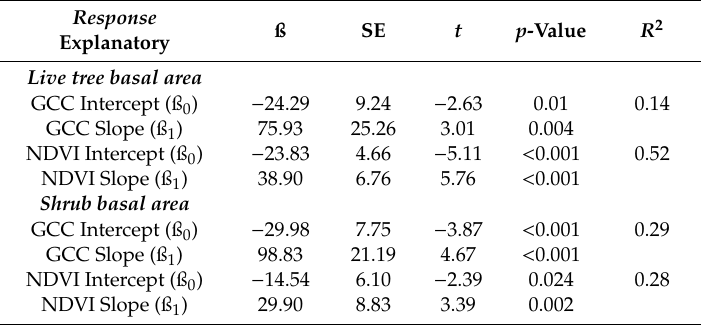
Table 5. Linear models testing how the aggregated means of GCC or NDVI with a 10-m bu ff er radius predict field-based measures of live tree and shrub basal area. For each model, we report the estimates of the coe ffi cients (ß) for the y-intercept and slope, Standard Error (SE), the test statistic value ( t ), p -value, and adjusted R 2 . Statistical relationships are visualized in Figure